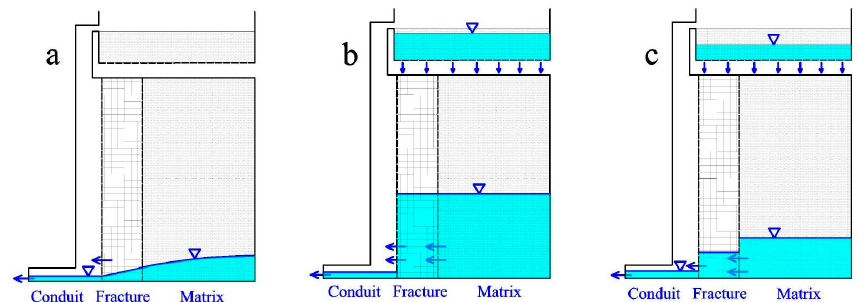
Figure 14. Stages of water charging and releasing process under light rainfall condition. ( a ) No rainfall for a long time; ( b ) Recharge in light heavy rain; ( c ) Recession after light rain.